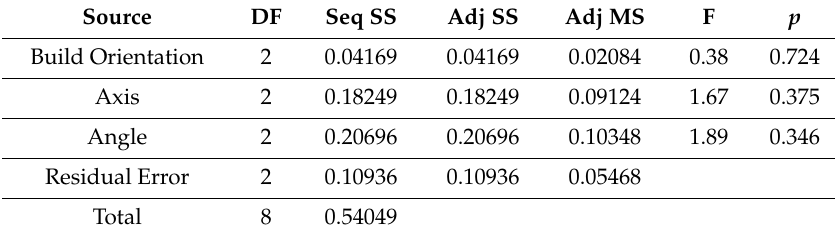
Table 6. ANOVA for percentage elongation obtained through Taguchi